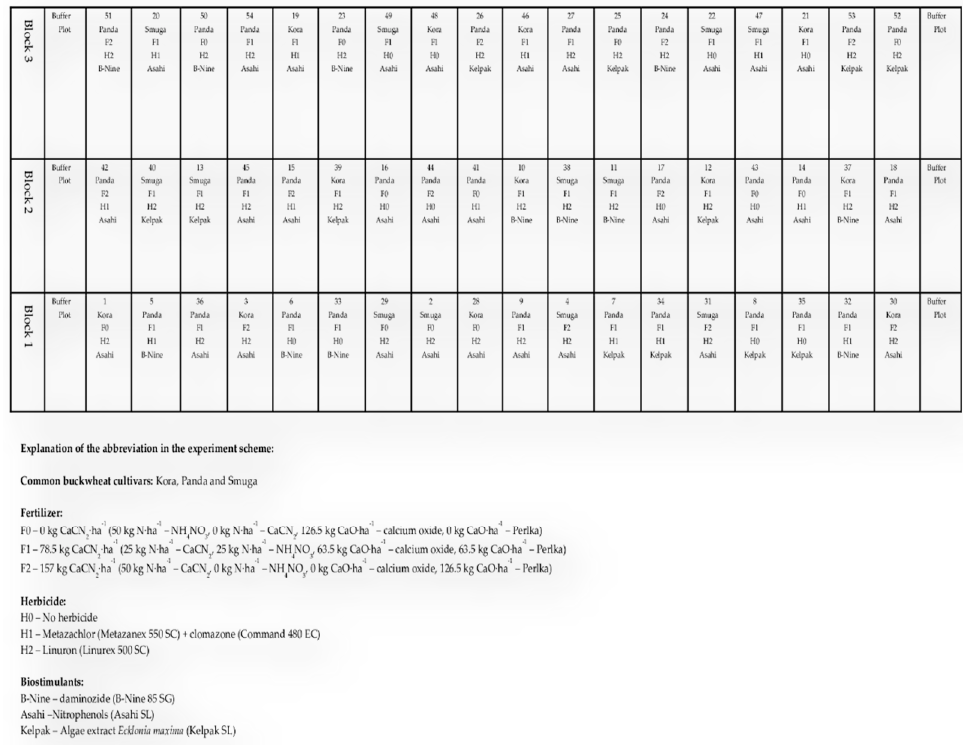
Figure A1. Scheme of the field experiment.